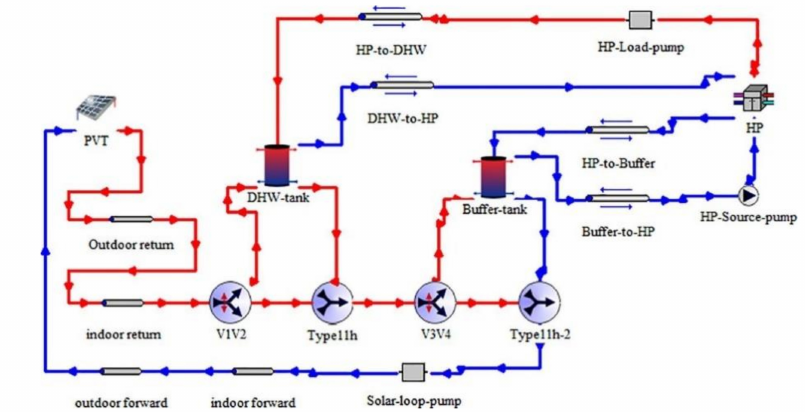
Figure 11. Seasonal coefficient of performance of different system configurations (reprinted from [84], with permission from publisher and information is added).